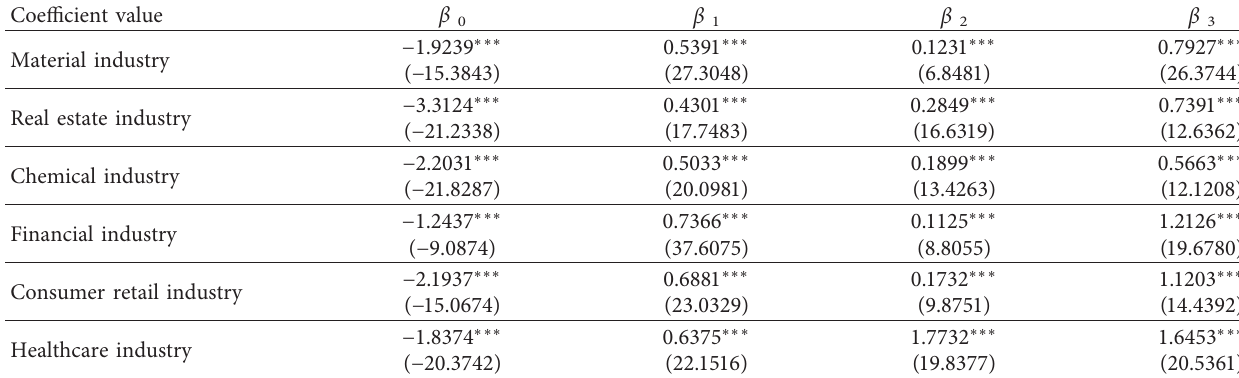
Table 8: Empirical test results of herding behavior in different